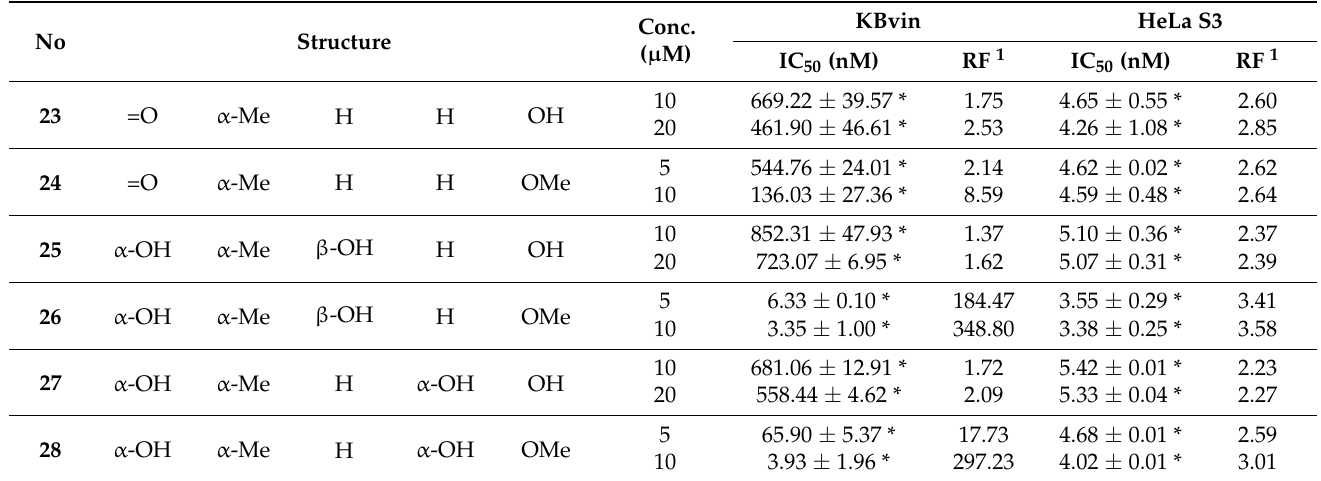
Figure 4. Dose–response curves of compounds 7 – 8 , 11 – 12 , and 25 – 26 in HeLa S3 ( A ) and KBvin ( B ). A summary of the structure–activity relationship (SAR) of triterpene derivatives are shown in Figure 5. In the R 1 and R 3 positions, the carbonyl substituent exhibited better chemoreversal ability than the other substituents. When the α -methyl substituent is epi- merized to β -methyl in the R 2 position, the inhibitory activity in KBvin cells was reduced. In the R 4 position, the hydrogen bond improved the collateral sensitivity. Finally, the R 5 ester derivatives were found to be more potent than their acid derivatives.